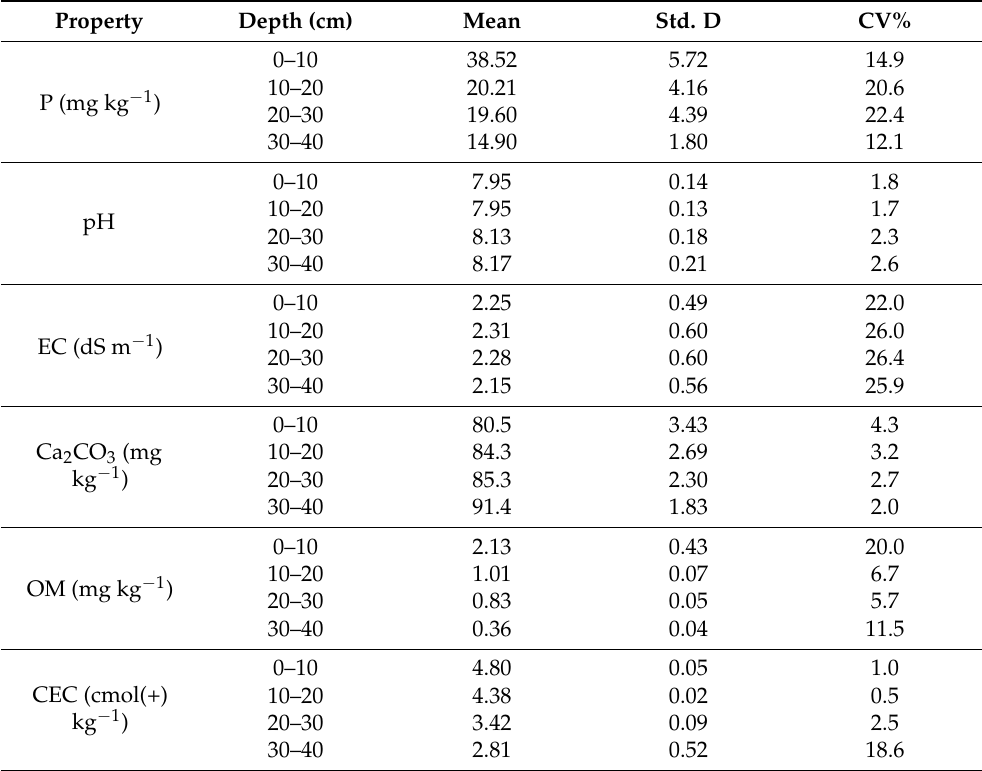
Table 2. Mean, standard deviation, and coefficient of variation for the selected properties of cultivated soil ( n = 20).